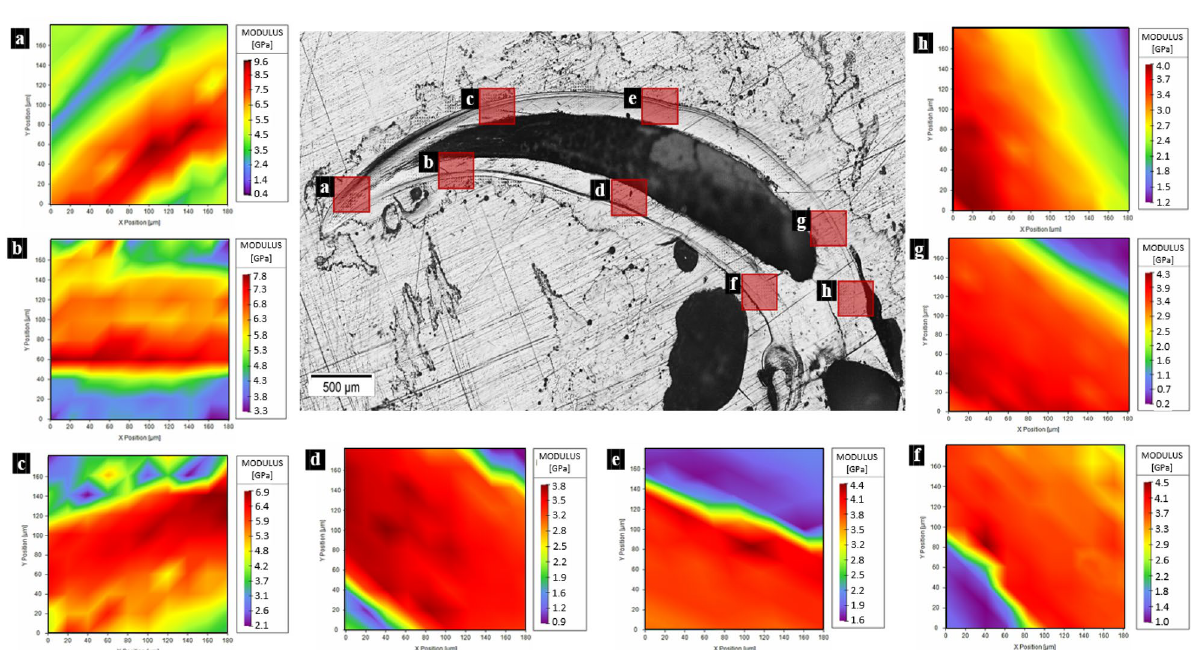
Figure 2. Map of the Young’s modulus in different sections of the spider fang in the longitudinal direction. In general, the outer layer of the sclerotized cuticle is stiffer than the internal. Images generated with the support of Nanoblitz 3d, Nanomechanics